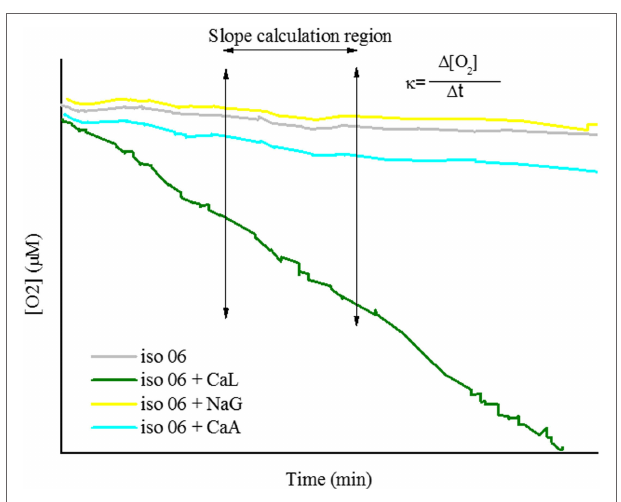
FigUre 2 | Typical graph obtained by oxygen consumption test. Four different curves are presented; the curve of autogenous respiration of vegetative cells (iso-06), the curve of vegetative cells respiring in calcium lactate (CaL) (iso-06 + CaL), the curve of vegetative cells respiring in calcium acetate (CaA) (iso-06 + CaA), and the curve of vegetative cells respiring in sodium gluconate (NaG) (iso-06 + NaG).